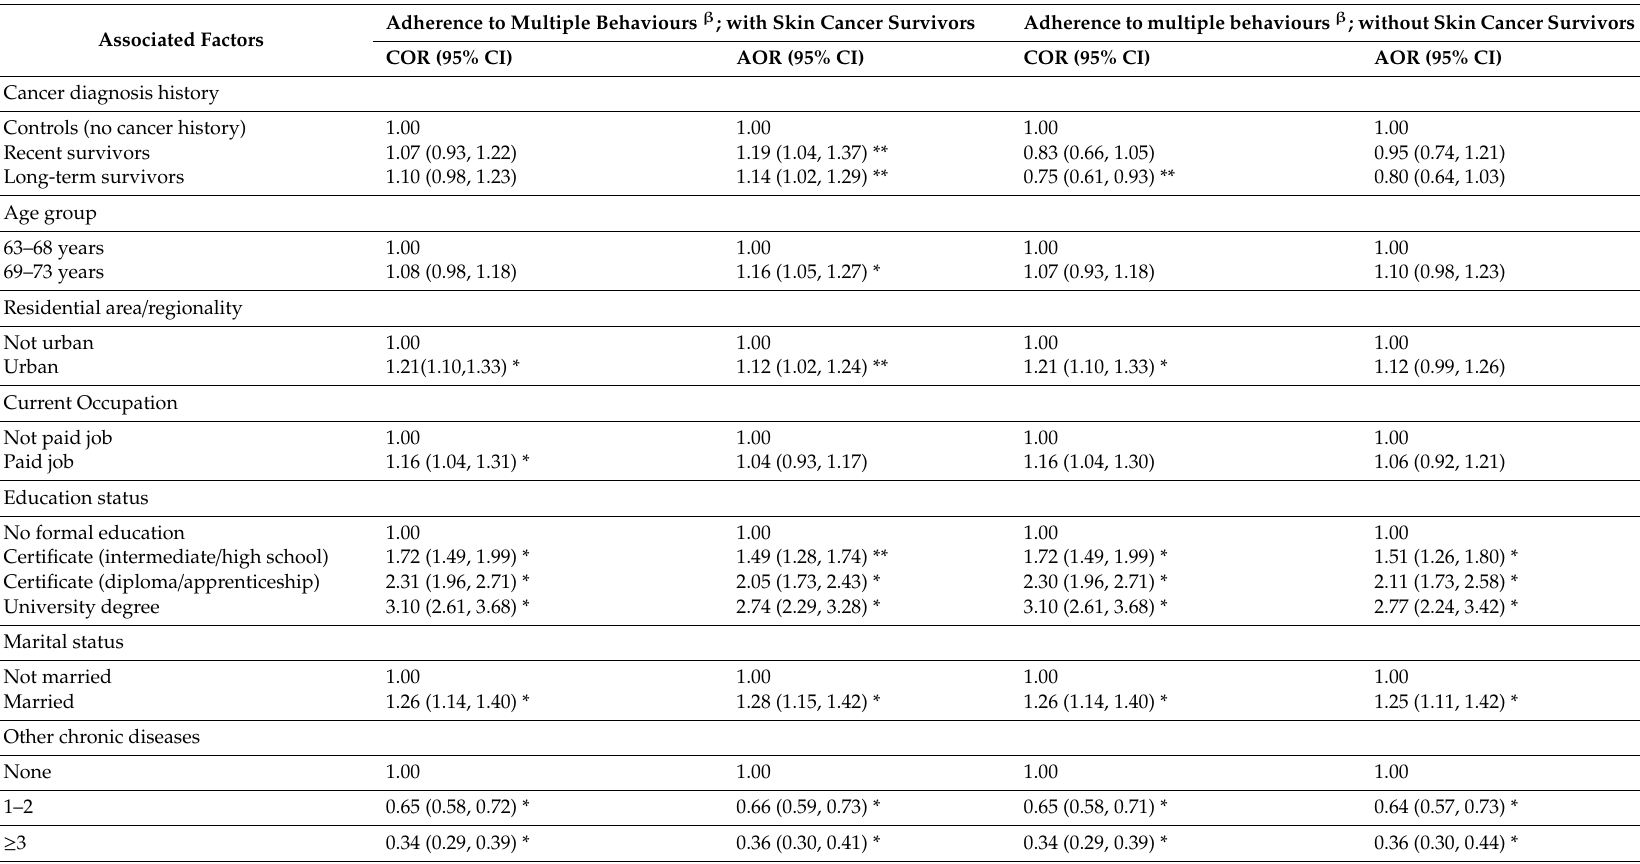
Table 5. A cancer diagnosis history and other covariates on adherence to multiple behaviours (with and without skin cancer). Adherence to Multiple Behaviours β ; with Skin Cancer Survivors Adherence to multiple behaviours β ; without Skin Cancer Associated Factors